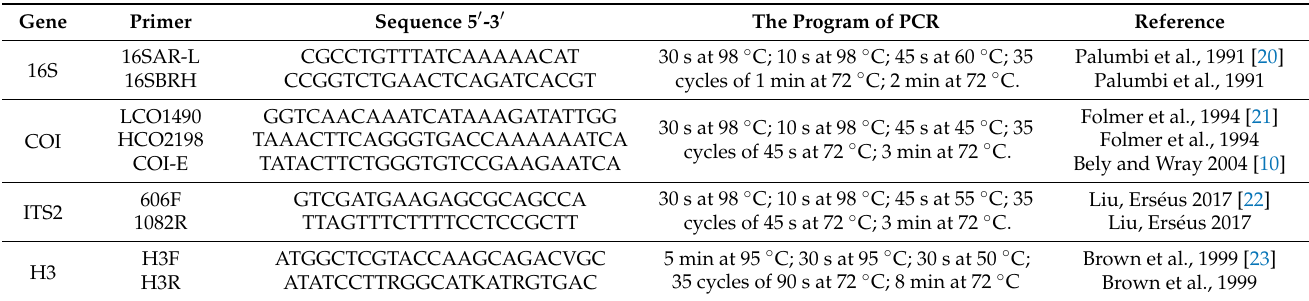
Table 3. Primers and programs used for amplification and sequencing of fragments of the mitochon- drial 16S and COI and nuclear ITS2 and H3